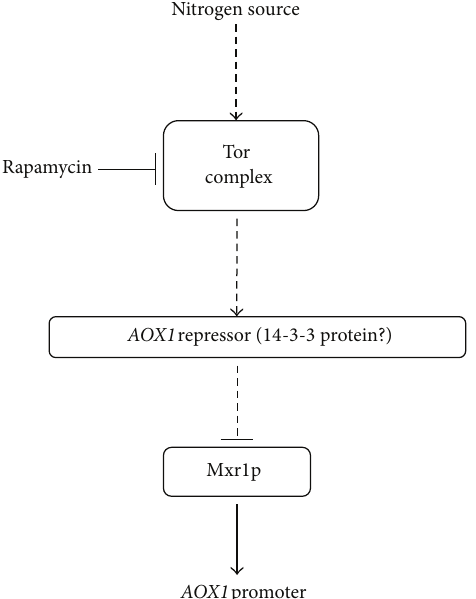
Figure 6: Proposed model of AOX1 gene regulation by nitrogen source. Activity of AOX1 promoter is modified depending on nitro- gensourceviaTor-signalingpathway.Proximatesignaltransduction is provided by proteins, involved in regulation of AOX1 gene by carbon